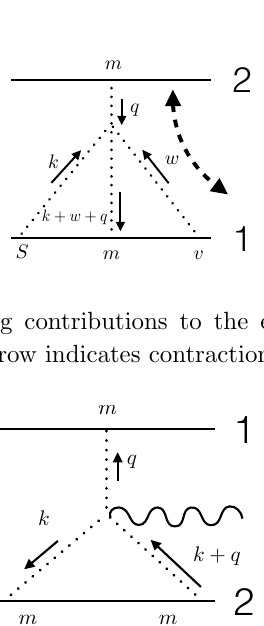
2 operator. The wiggly line C